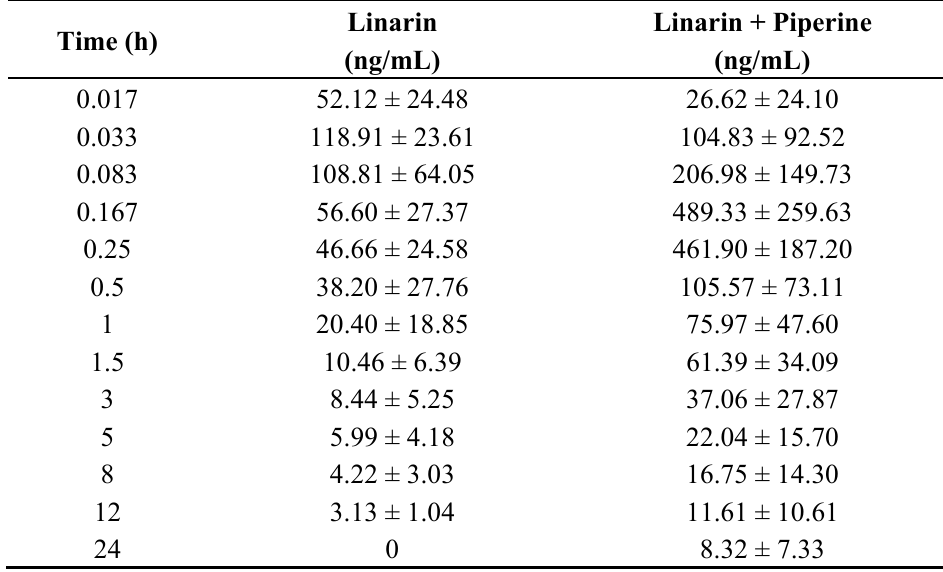
Table 1. Plasma concentrations of linarin at different time points following oral administration of linarin alone and in combination with piperine. (mean ± SD, n =